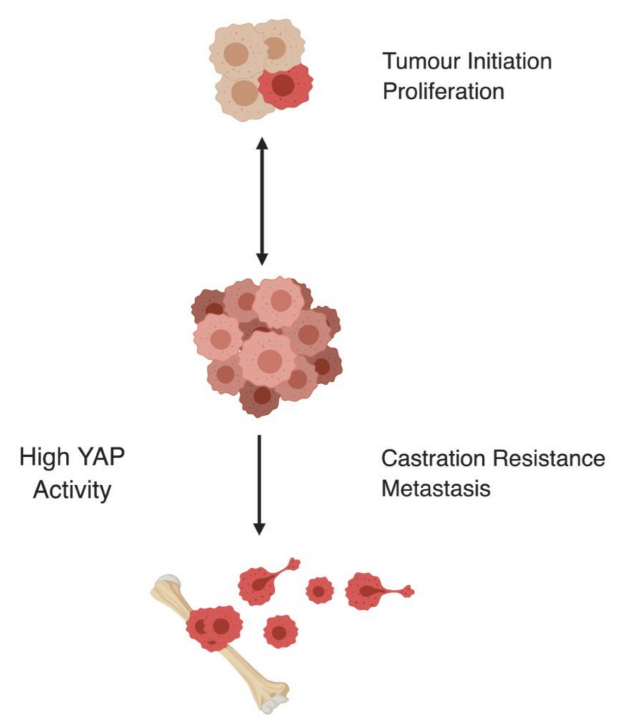
Figure 2. Schematic overview of YAP activity levels across di ff erent stages of prostate cancer (PCa). YAP regulates multiple stages of PCa